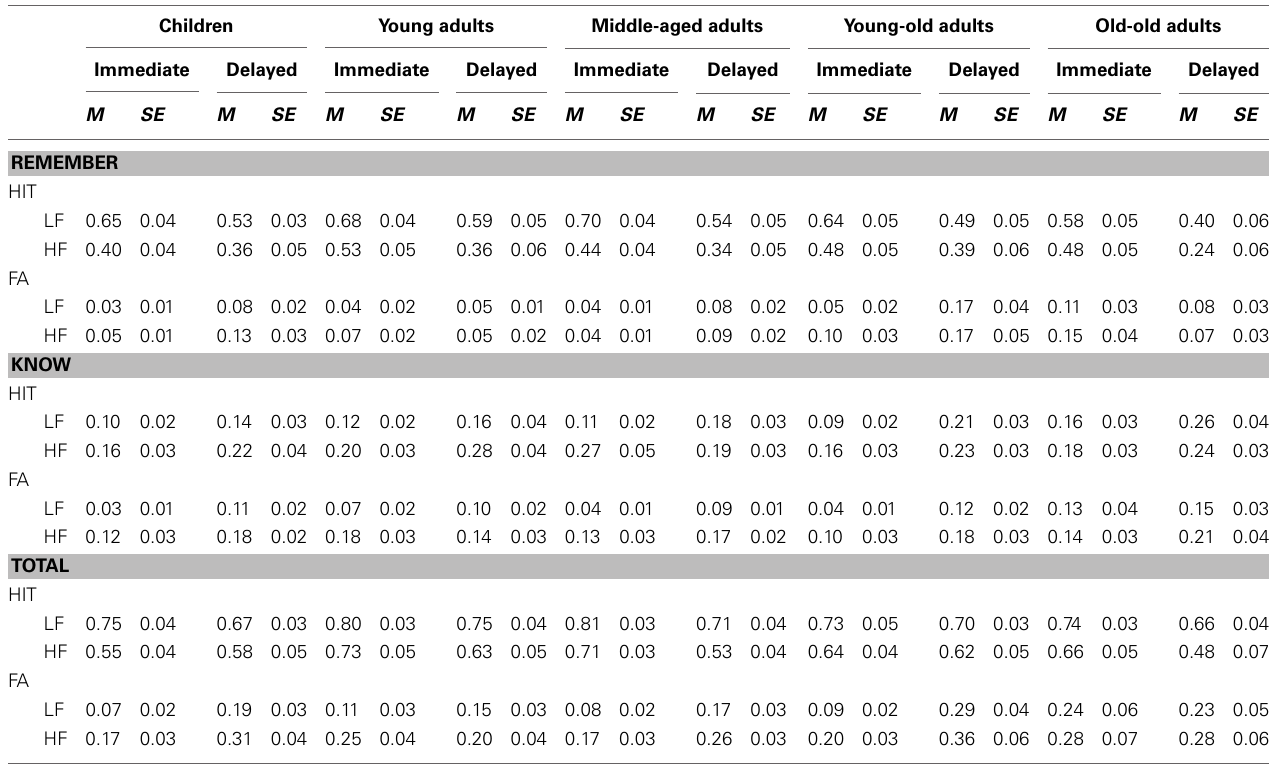
Table 2 | Experiment 1: Means and standard errors of hits and false alarm